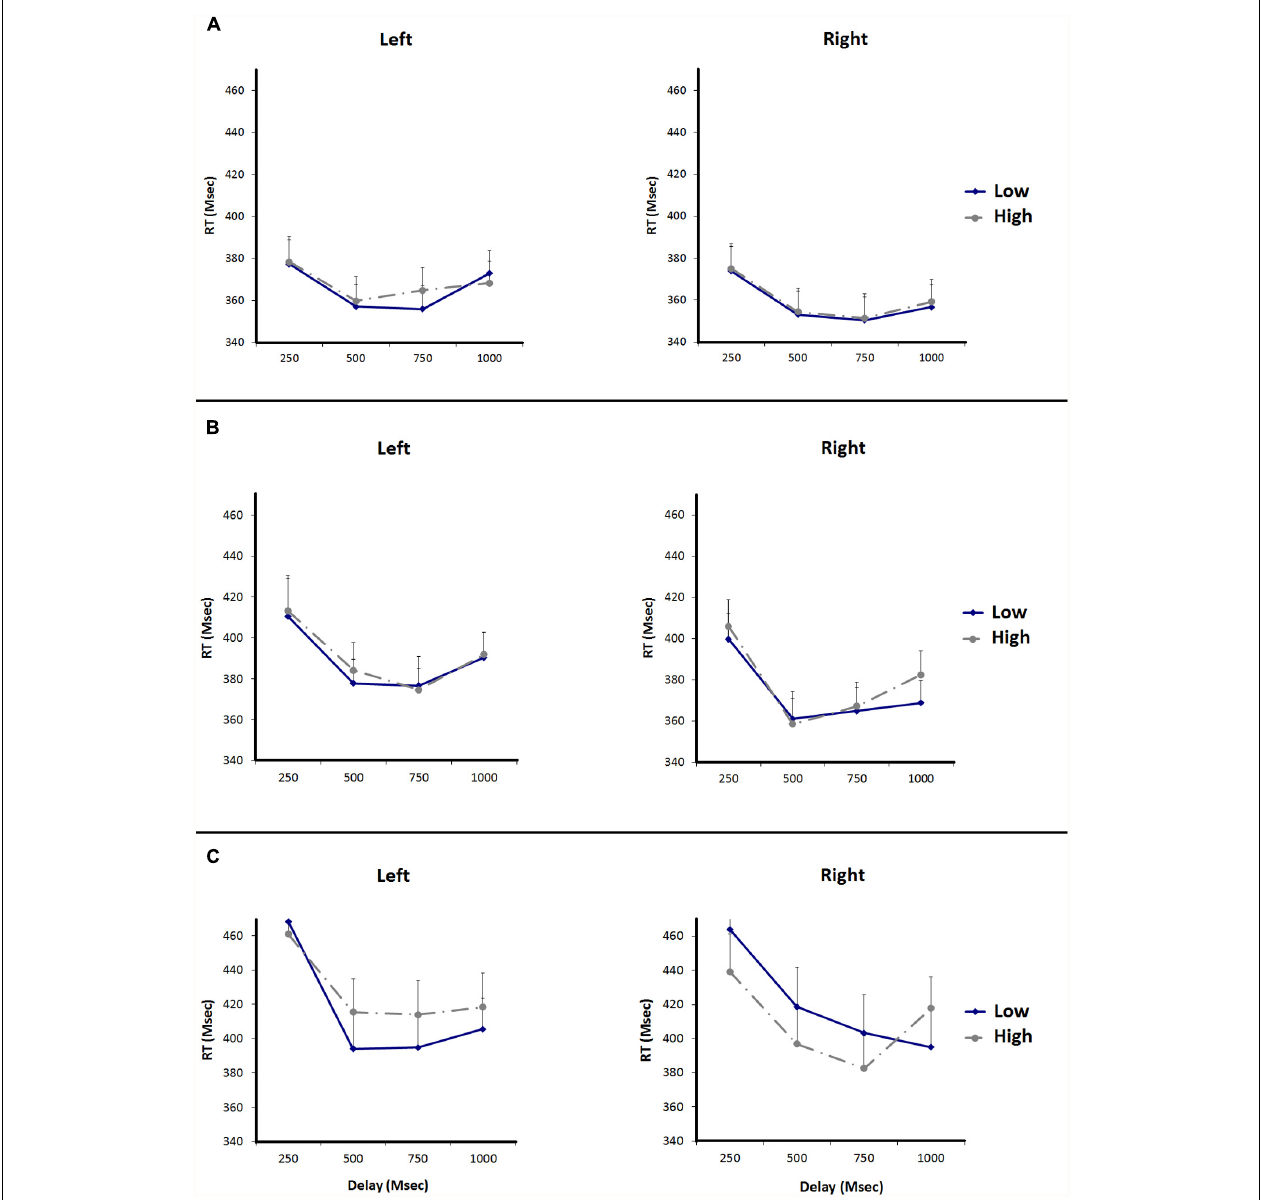
FIGURE 2 | Reaction times for the target detection task of experiments 1, 2, and 3. Error bars represent standard errors of the mean difference between adjacent data points. (A) Shows the RTs of Experiment 1, (B) shows the RTs of Experiment 2, and (C) shows the RTs of Experiment